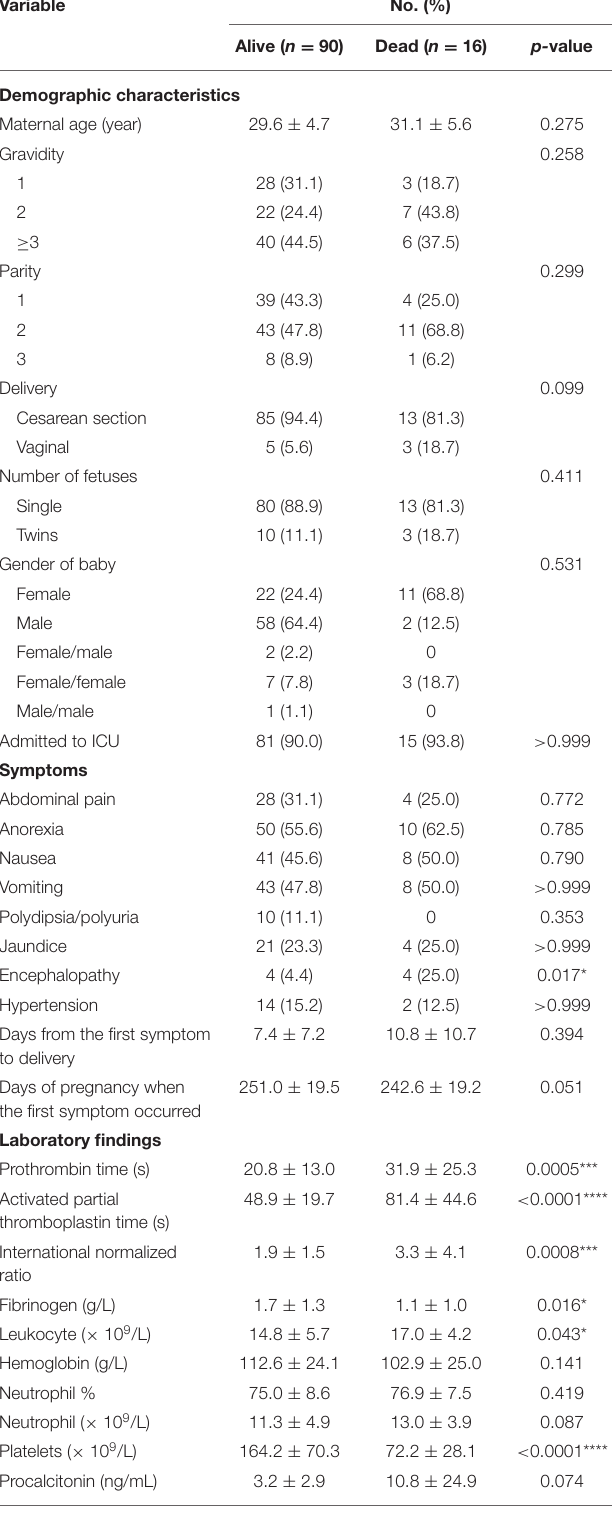
TABLE 9 | Comparison of demographic, clinical, and laboratory characteristics between fetal survivors and non-survivors. Variable